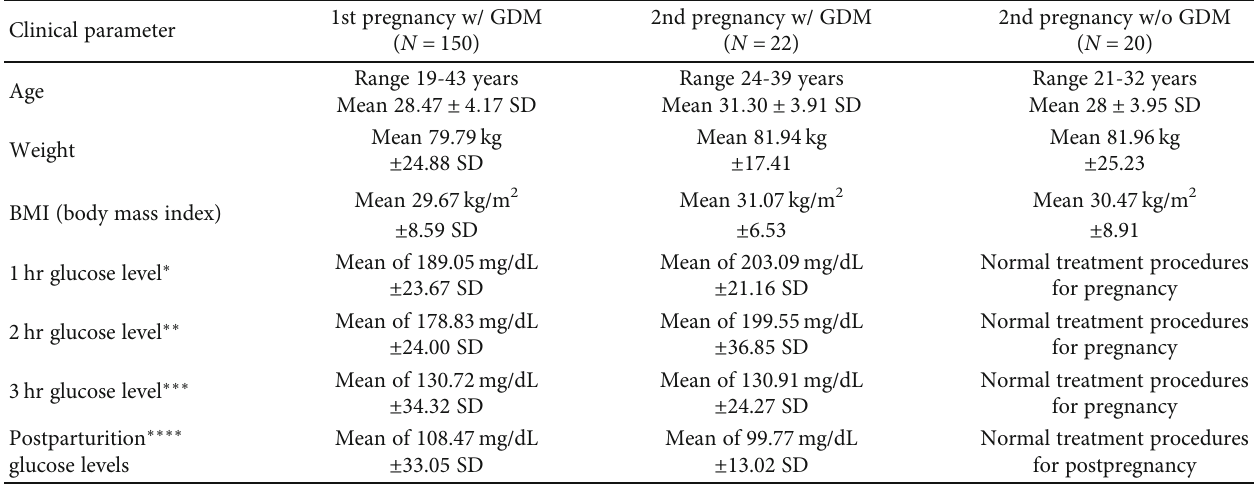
Table 1: Clinical parameters for data analysis 1.